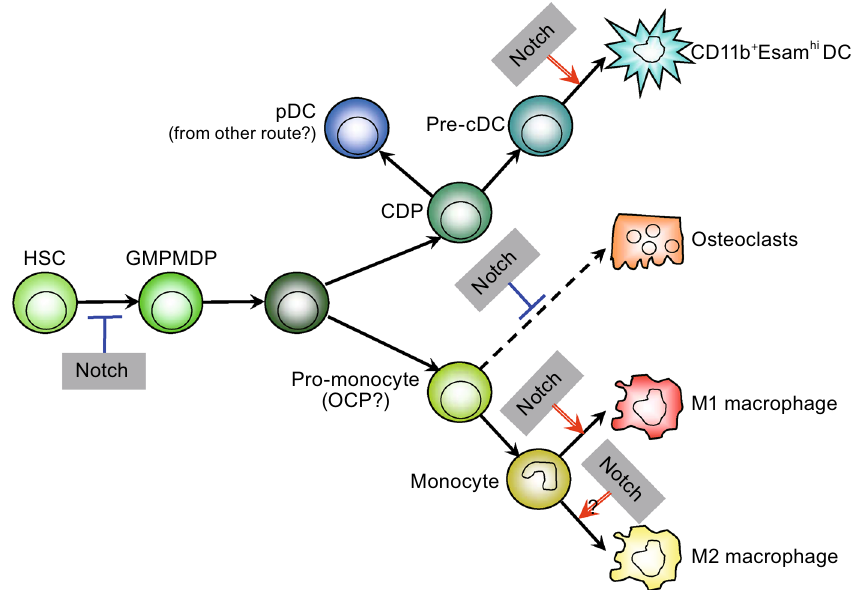
Figure 2. Regulation of myeloid cell development and differentiation by Notch signaling. Notch signaling critically controls multiple steps of myeloid cell development and differentiation program including early myelopoiesis, development of certain DC population, osteoclast differentiation, and in fl ammatory macrophage polarization. Abbreviations: HSC, hematopoietic stem cell; GMP, granulocyte-macrophage progenitor; MDP, macrophage-dendritic cell progenitor; CDP, common dendritic cell precursor; OCP, osteoclast precursor; pDC, plasmacytoid